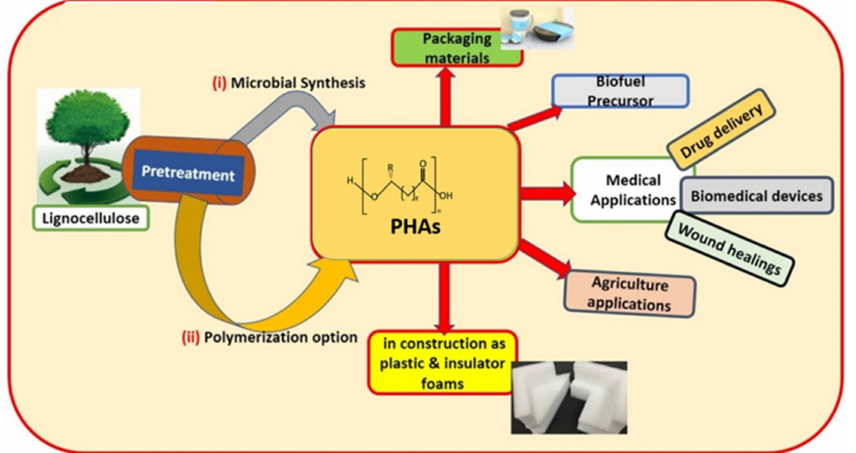
Figure 1. Applications of polyhydroxyalkanoates (PHAs) in various fields. Reproduced with permission from [17]. Copyright 2020 Elsevier